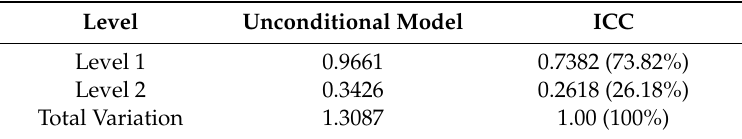
Table 6. Result of unconditional model